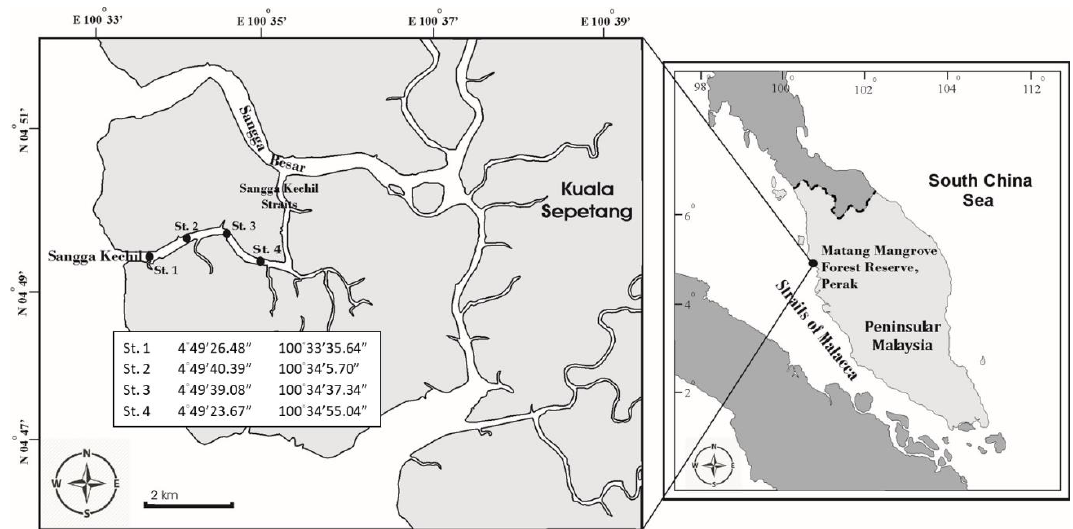
Figure 1. Map showing the locations of four selected sampling sites of the study area in the Sangga Kechil estuarine-mangrove area, Matang, Perak.